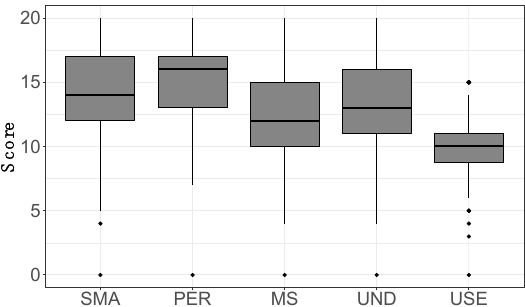
Figure 2. Boxplots of the scores obtained in each scale of the CBA ‐ H. Scale legends with Cronbach’s alpha values in parentheses; ( A ) A = State anxiety (0.87); HF = Health ‐ care related fears (0.54); SD = Situational depression (0.67); ( B ) ED = Depressive mood (0.71); PS = Perceived psychophysical stress (0.68); PW = Psychophysical wellbeing (0.57); ( C ) EI = Excessive involvement (0.42); H = Hostility (0.50); HI = Haste and impatience (0.59); I = Irritability (0.32); ID = Interpersonal difficulties (0.64); IR = Inability to relax (0.64); IV = Introversion (0.76); LC = Leadership/Competitiveness (0.10); N = Neuroticism (0.79); SA = Social anxiety (0.73). Sample size, n = 352.